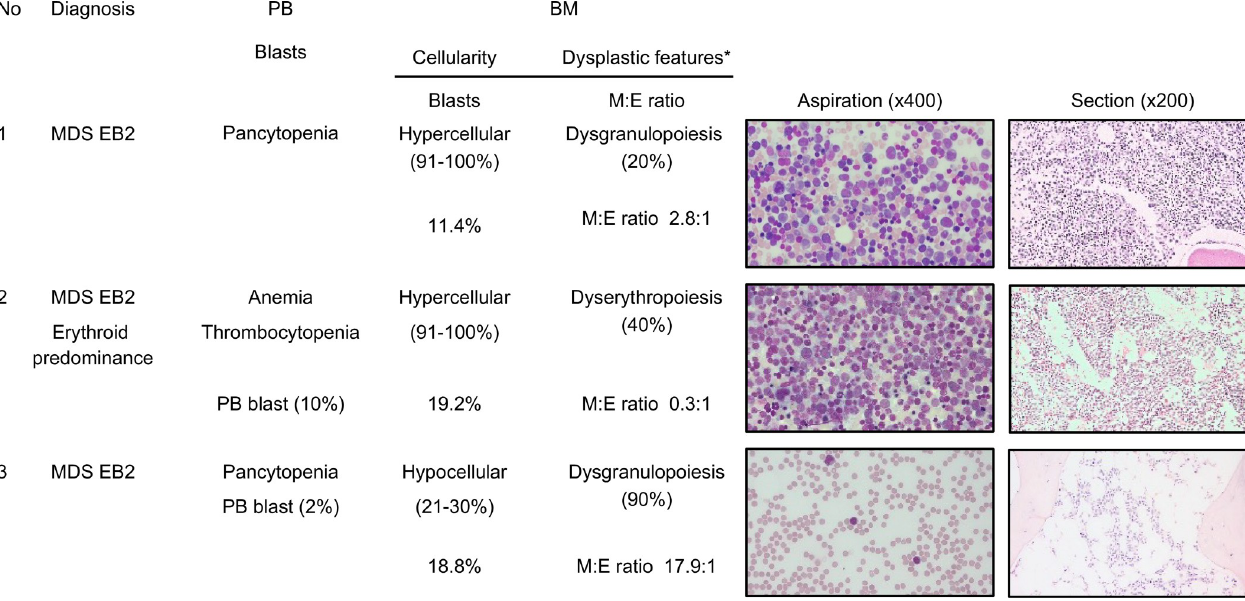
band had a history of taking anti-epilepsy drugs and showed persistent thrombocytopenia despite the discontinuation of antiepileptic drugs. The patient’s first bone marrow